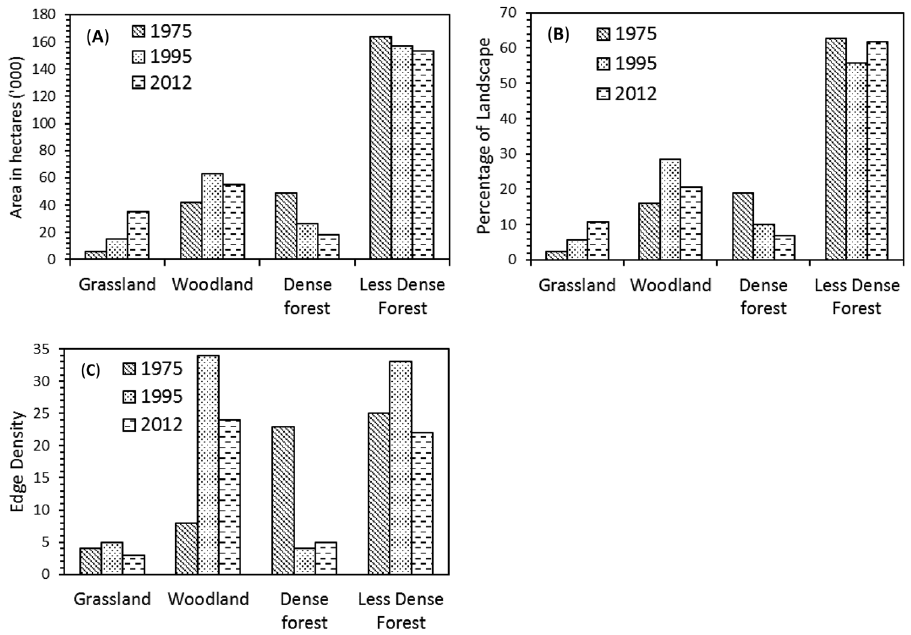
Figure 3. Temporal patterns of total area coverage ( A ), percentage of landscape ( B ) and edge density ( C